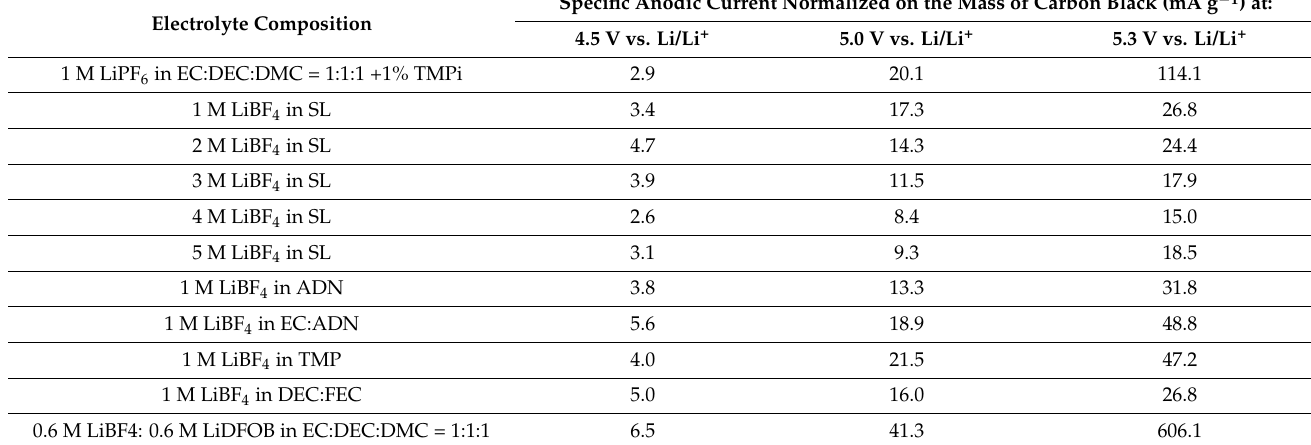
Table 1. Cont. Specific Anodic Current Normalized on the Mass of Carbon Black (mA g − 1 ) Electrolyte Composition